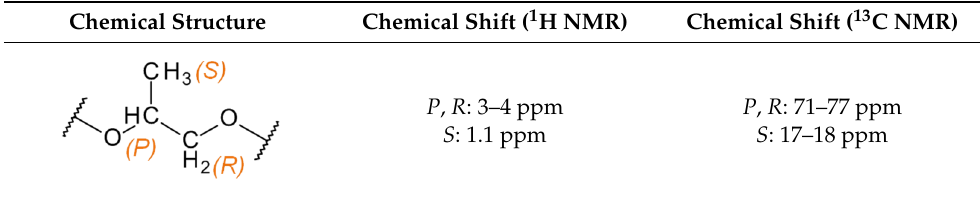
Table 3. Chemical structures and assignment of characteristic groups to signals in 1 H and 13 C NMR spectra.